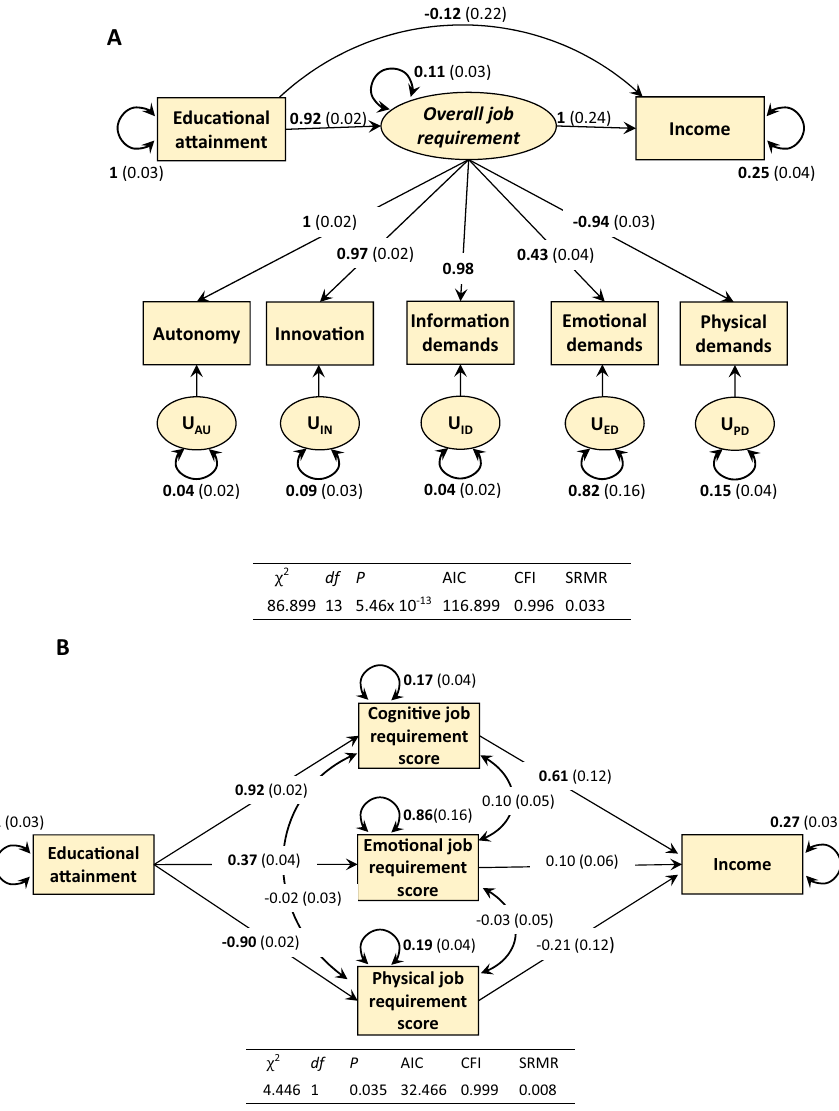
Figure 3. Analyses on the role of latent factors of job attainment genetically mediating educational attainment and income. ( A ) Fitting Genomic Structure Equation Modelling (Genomic SEM). Educational attainment, job attainment, and income are observed variables based on GWAS summary statistics. Overall job requirement is a latent (unobserved) variable. Beyond the path on overall job requirement , a direct path from educational attainment and income was not significant. As the model did not converge by including all six job characteristics simultaneously, we excluded complexity since its composite nature and high correlations with other traits. ( B ) A two-step factor score path analysis. The scores of three factors to present cognitive, emotional, and physical job requirement from exploratory factor analysis for job attainment, were calculated. The income was regressed on educational attainment and factors scores. Standardized beta coefficients are presented, as well as the test statistics for the